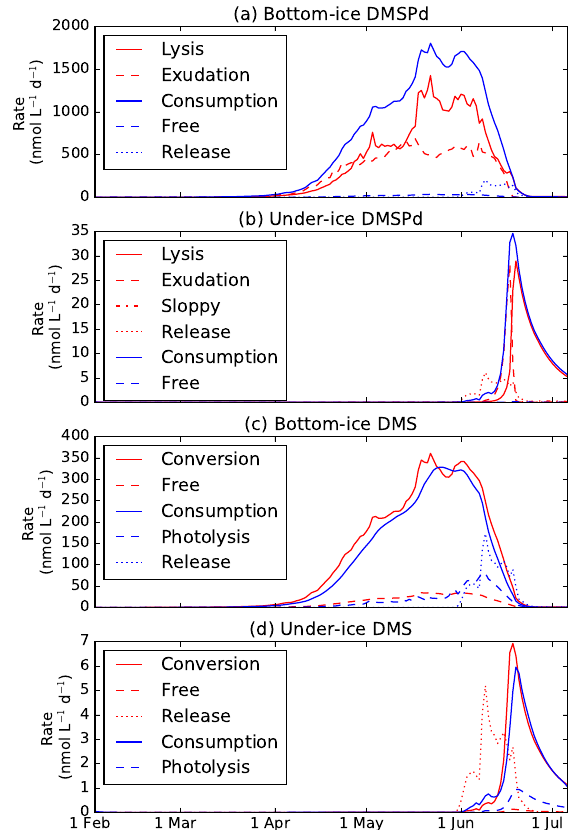
Figure 4. Simulated time series of daily mean production (red) and removal (blue) rates (nmolL − 1 d − 1 ) of (a, b) DMSPd and (c, d) DMS (a, c) in the bottom 3cm ice and (b, d) in the upper- most layer (0.5m below the ice) of the water column. In panels (a) and (b) , the sources for DMSPd are cell lysis (Lysis; solid red), ex- udation (Exudation; dashed red), and sloppy feeding (Sloppy; dash- dot red in panel (b) only) while its sinks are bacterial DMSPd con- sumption (Consumption; solid blue) and free DMSP-lyase (Free; dashed blue). In panels (c) and (d) , the sources for DMS are bac- terial DMSPd-to-DMS conversion (Conversion; solid red) and free DMSP-lyase (Free; dashed red), while its sinks are bacterial DMS consumption (Consumption; solid blue) and photolysis (Photolysis; dashed blue). Release from the bottom ice (Release; dotted) is a sink for the bottom-ice DMSPd (a) and DMS (c) , while it is a source for the under-ice DMSPd (b) and DMS (d)